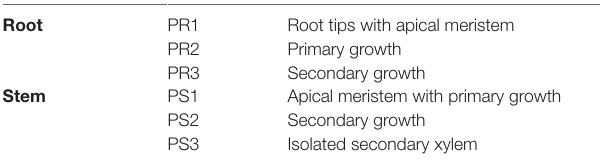
TaBle 2 | Experimental design describing sampling of Populus trichocarpa pioneer roots and